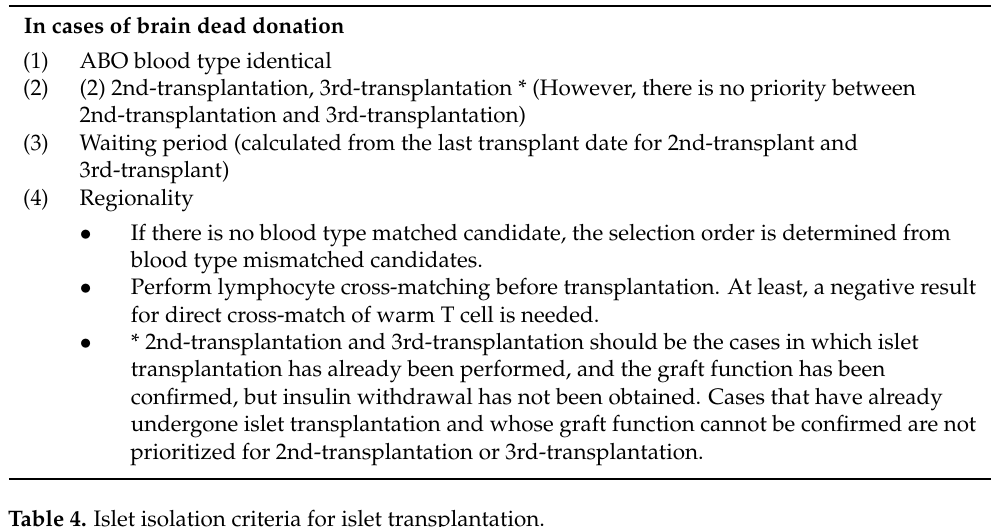
Table 4. Islet isolation criteria for islet